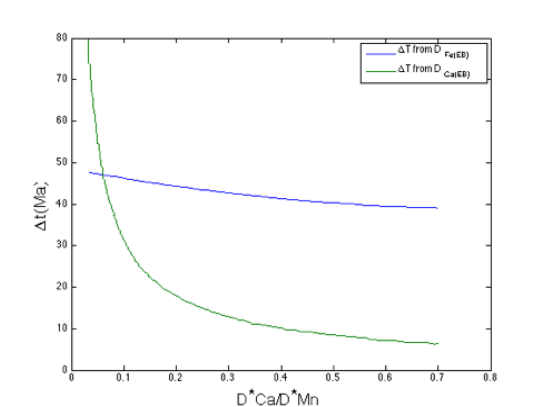
Figure 5. Variations in calculated time scales ( Δ t) as functions of D Fe(EB) and D Ca(EB) , derived from assumed values of D * Ca . [ 14 ]